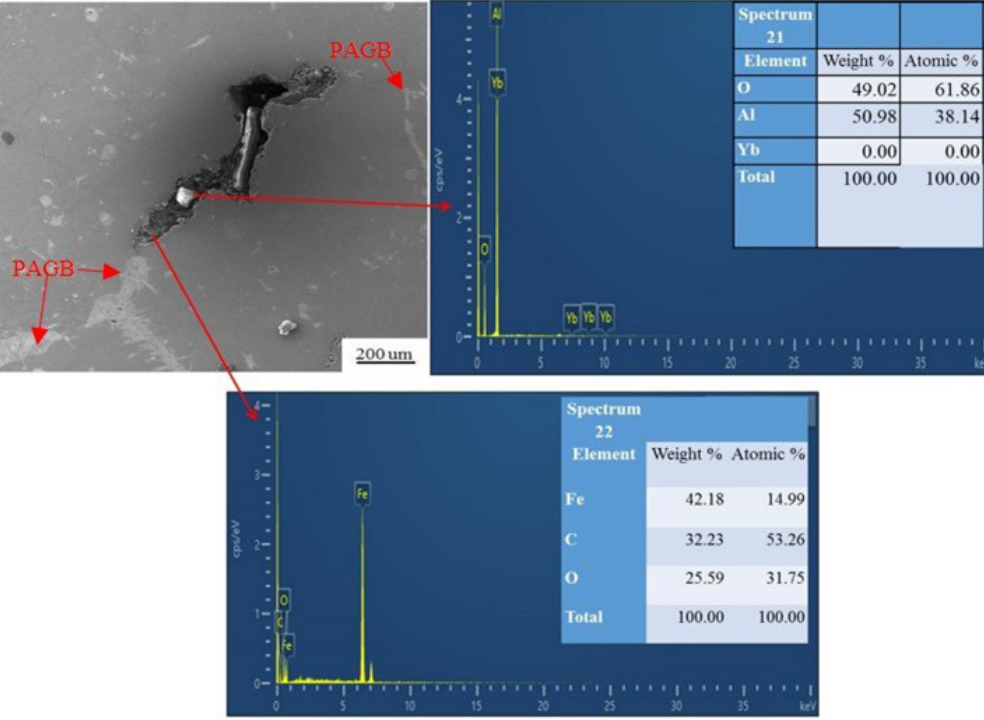
Figure 4. SEM image and EDS of the crack region at